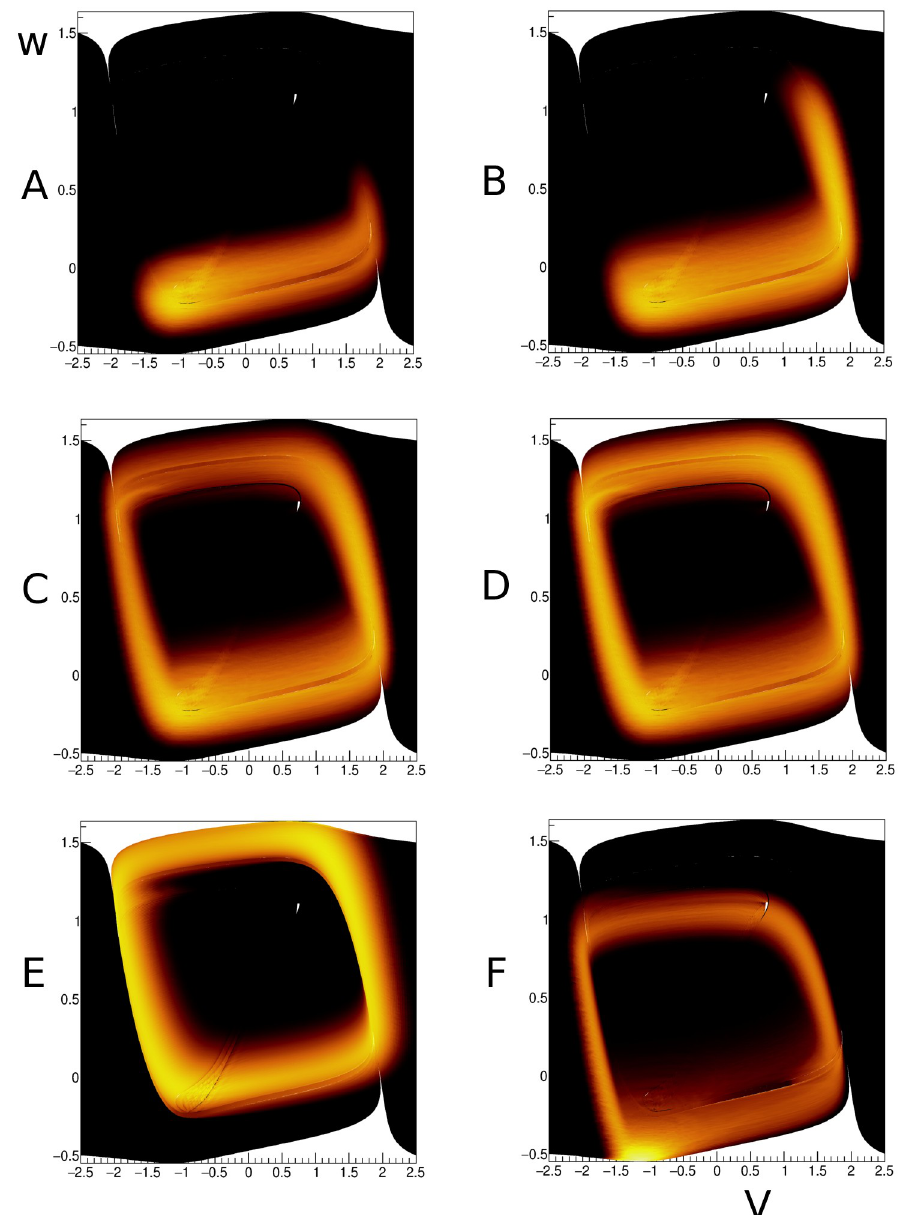
Fig 13. A-D: Evolution of the density at t = 5, 10, 50 s an steady state for a diffusive input ( J = ± 0.02, ν = 20 spikes/s). E: excitatory input for a weak rate, but with large synaptic efficacy ( J = 0.1, ν = 2 spikes/s). F: inhibition captures most neurons at the fixed point, a weak ghost cycle of neurons that escape by fluctuation is visible, but is considerably displaced compared to the standard limit